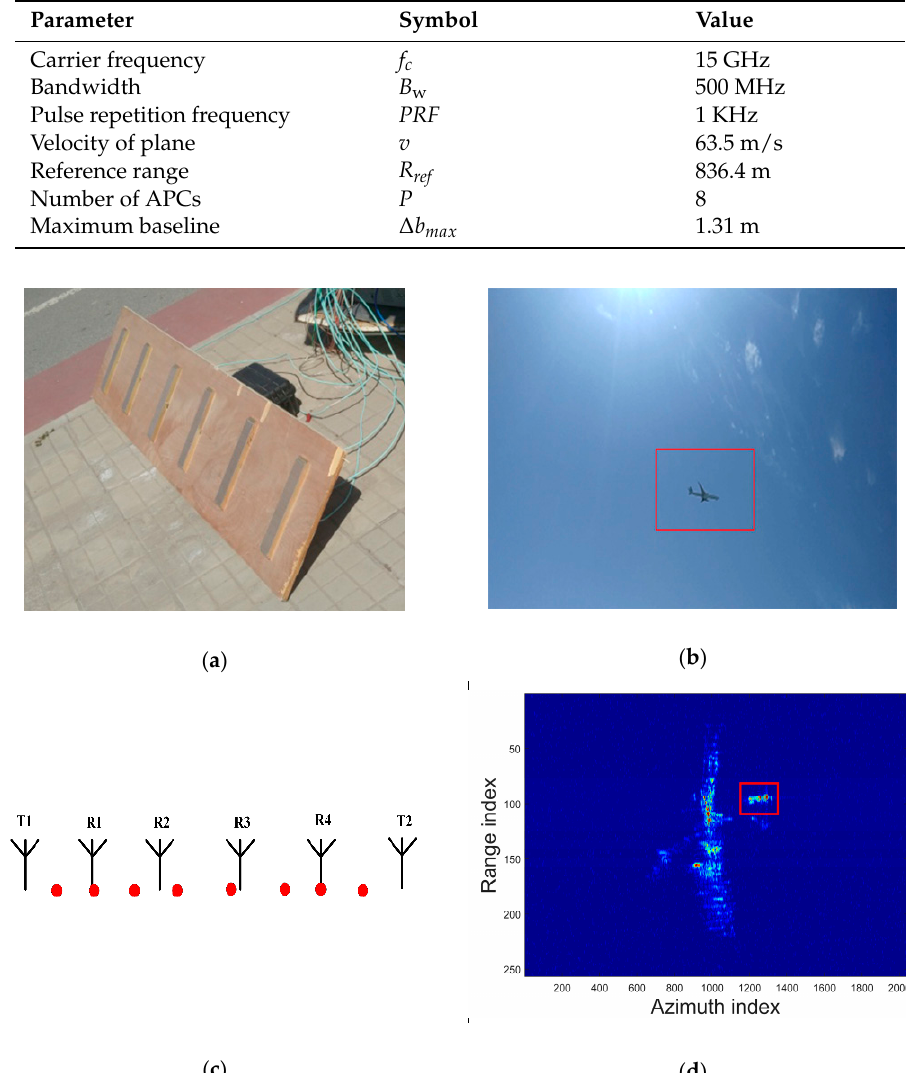
Figure 3. Array ISAR system configuration and ISAR images. ( a ) array ISAR system; ( b ) observed airplane; ( c ) distribution of APCs; ( d ) ISAR image by one of the channel.